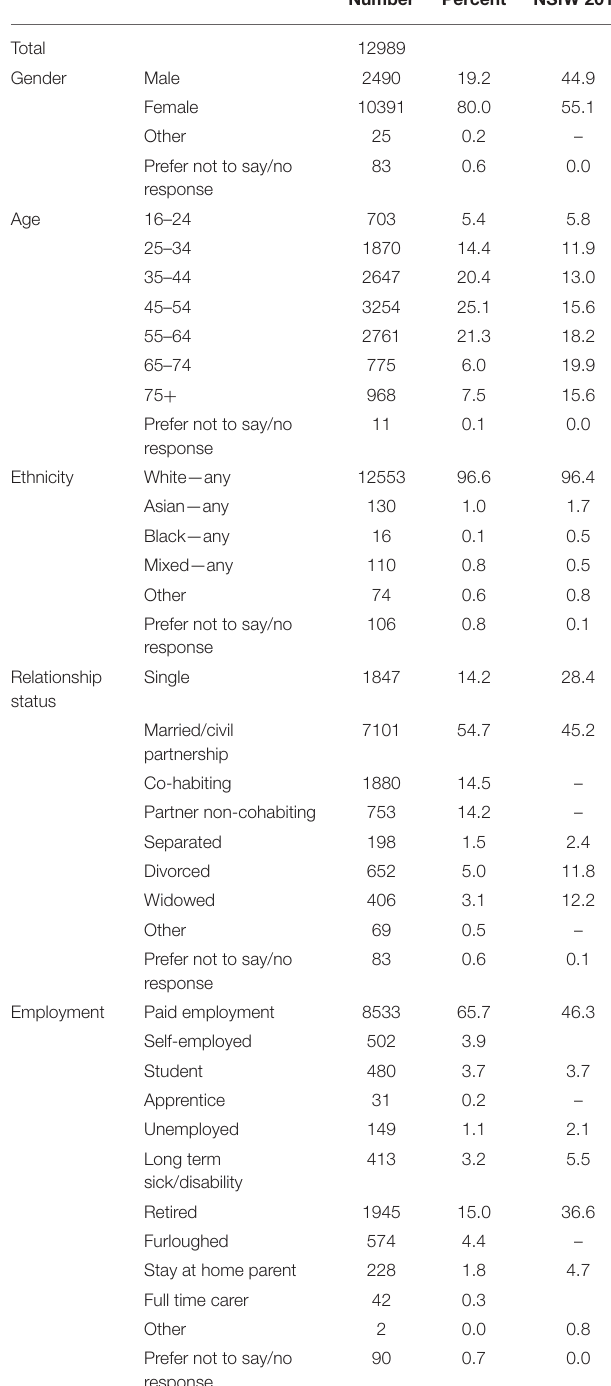
TABLE 1 | Demographic information on the sample and that of the NSfW